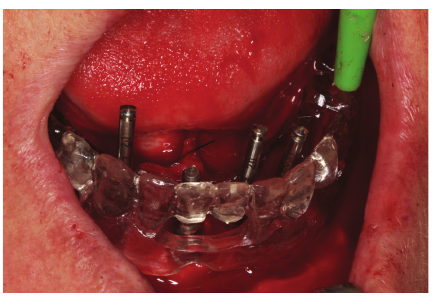
Figure 5: Implant placement.